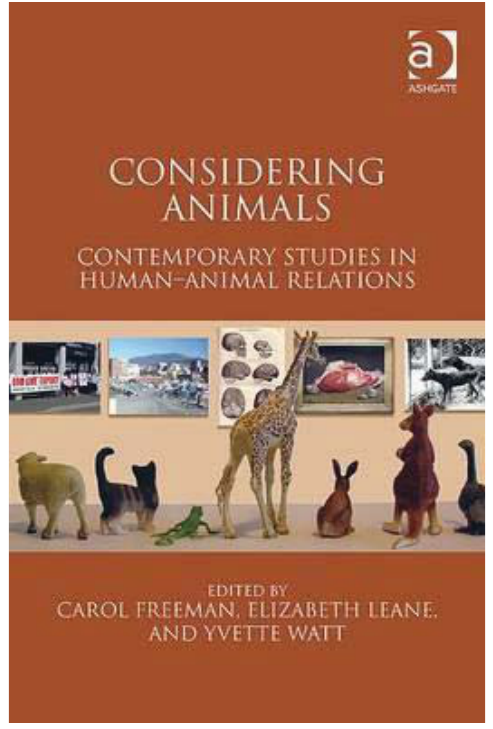
Figure 1. Dust jacket of Considering